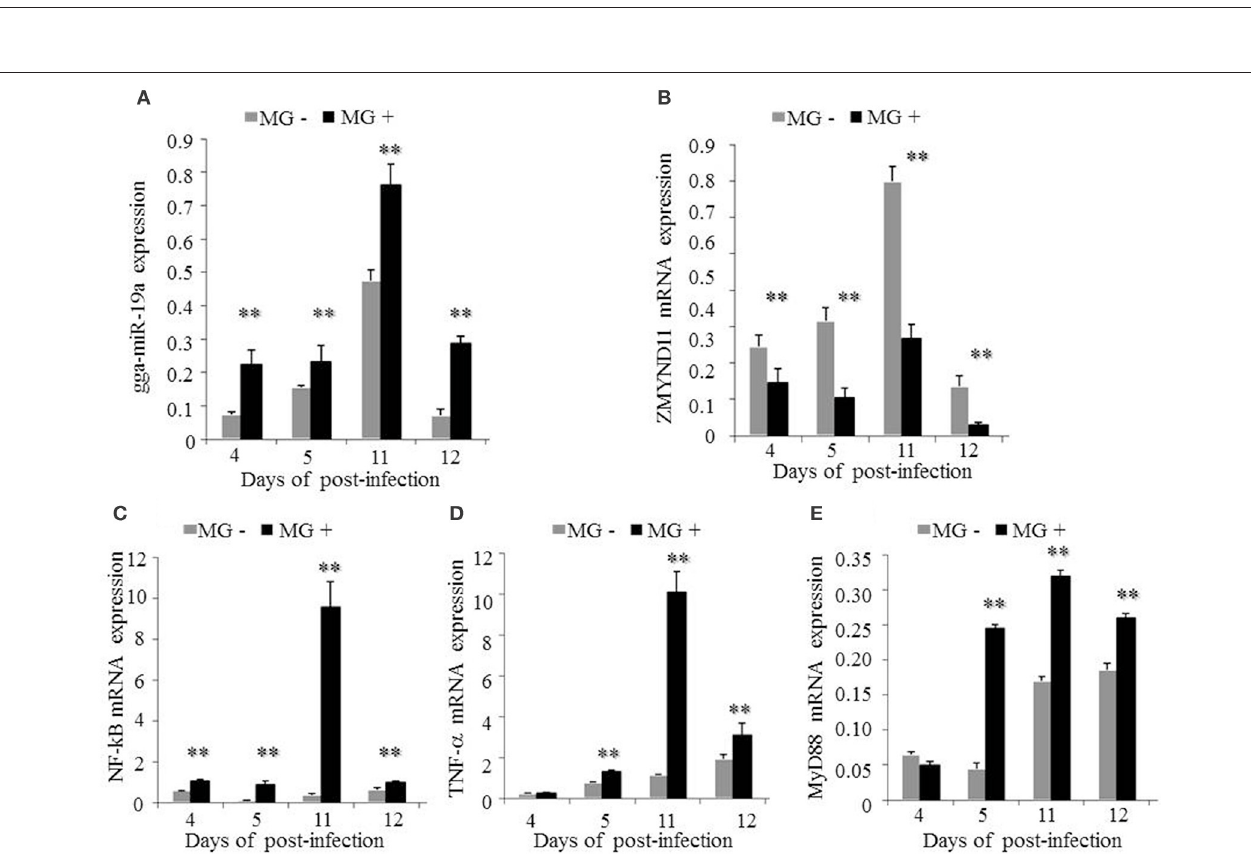
FIGURE 9 | Effects of MG infection on the expression of gga-miR-19a, ZMYND11, NF- κ B, TNF- α and MyD88 in the lungs of chicken embryos. The chicken embryos were infected by MG-HS as described in the Material and Methods. On the 4, 5, 11, and 12th days post-infection, the lungs of infected chicken embryos were processed, and the expression of gga-miR-19a (A) , ZMYND11 (B) , NF- κ B (C) , TNF- α (D) , and MyD88 (E) were measured by RT-qPCR. All samples were normalized to GAPDH. All values are represented as the mean ± SD of three independent experiments in triplicate. Significant differences are denoted as ** P <